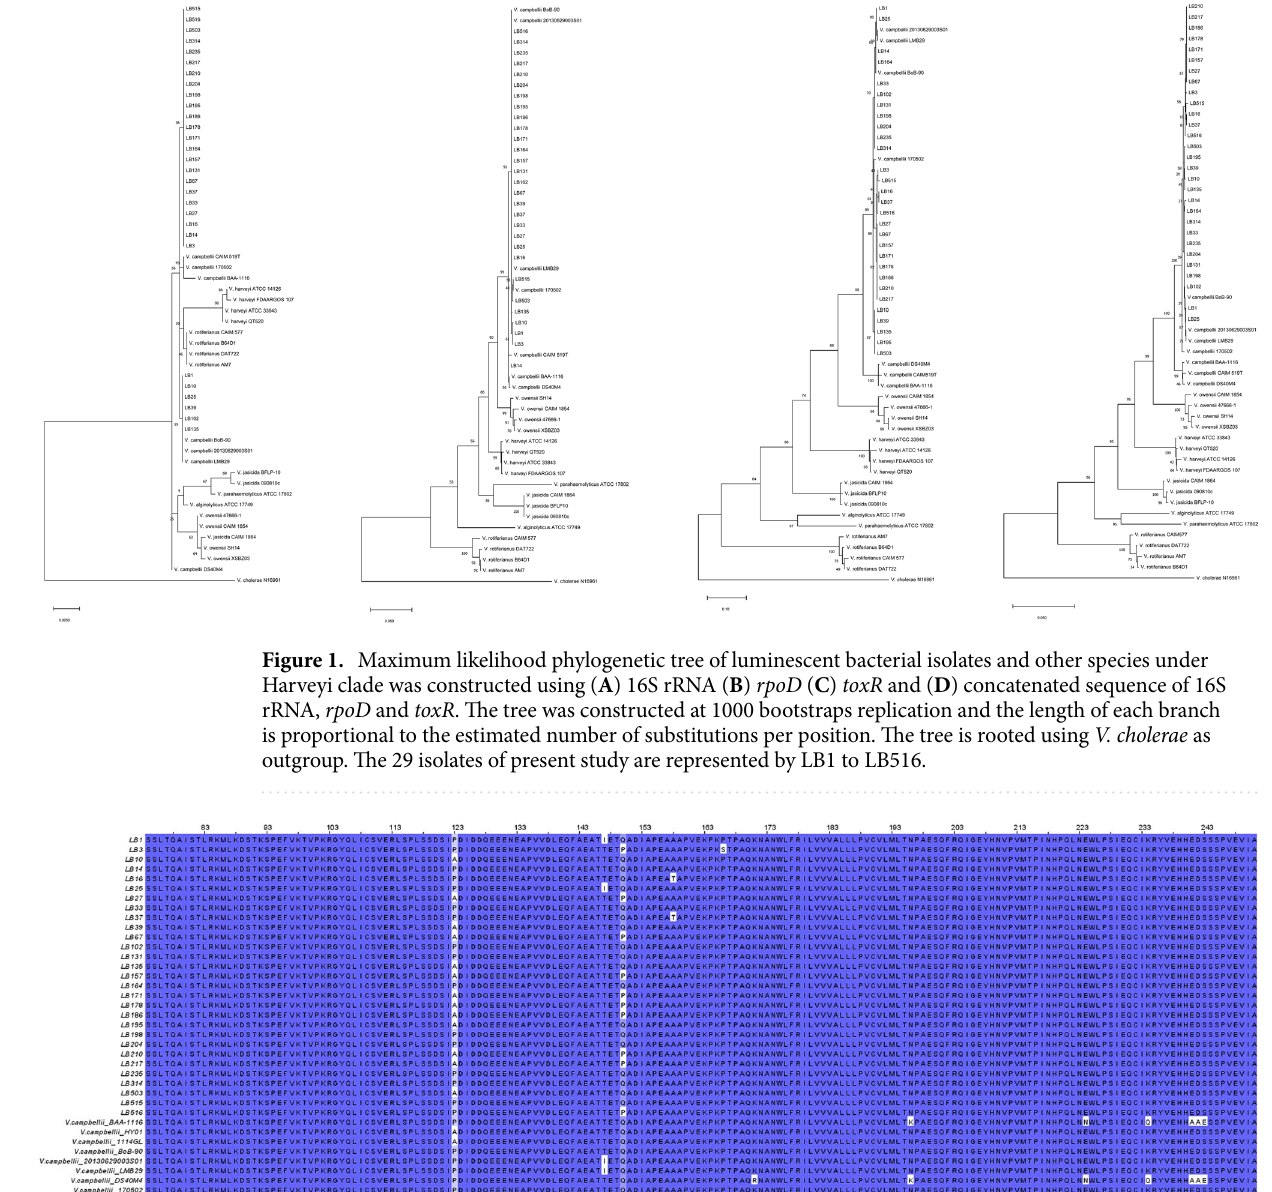
Figure 2. Amino acid sequence alignment of the variable region of ToxR of V.